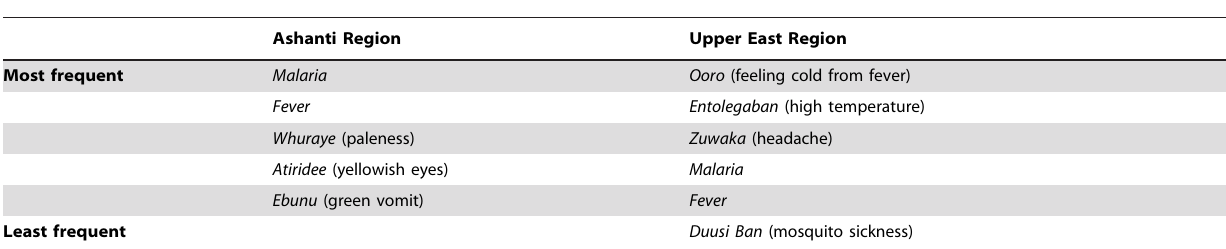
Table 3. Malaria